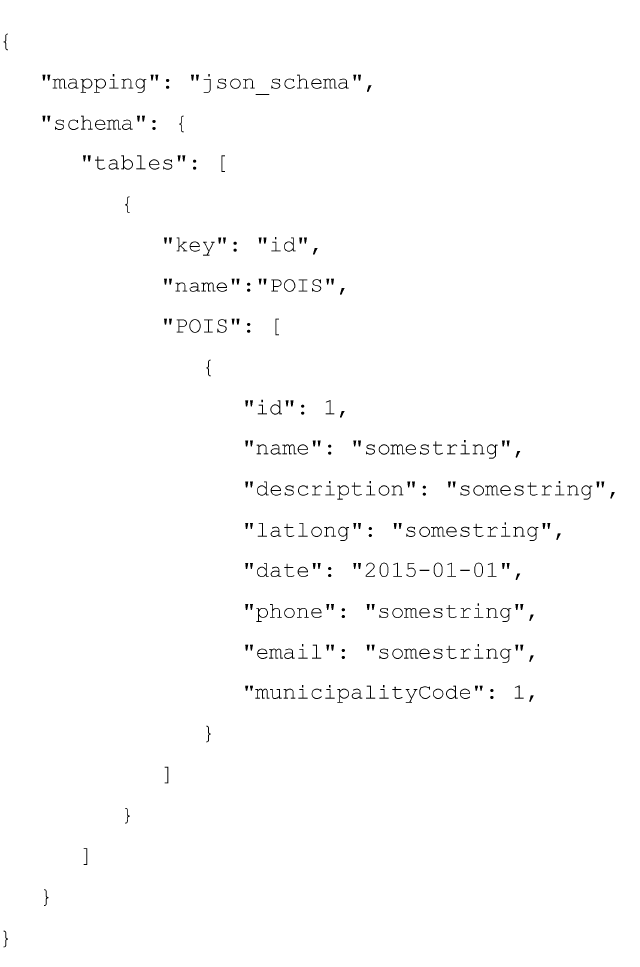
Figure 10. Example of user created dataset’s description.